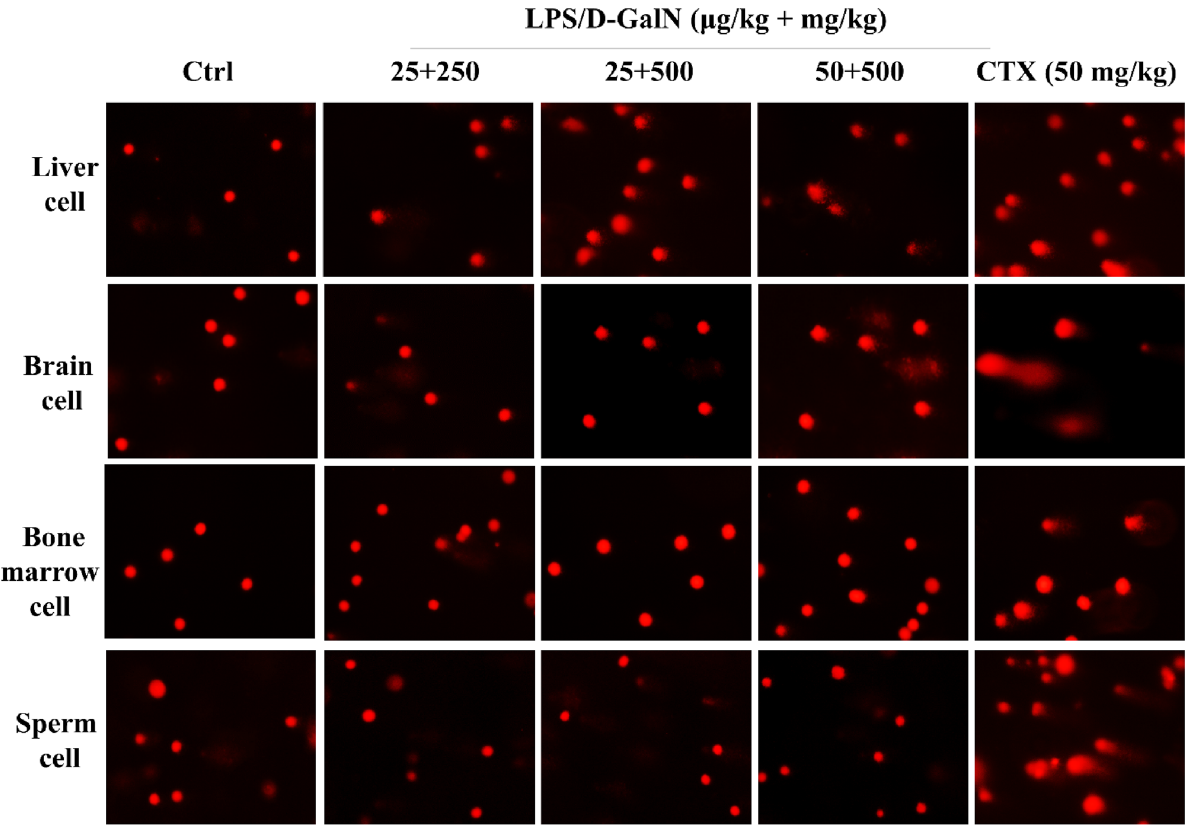
Figure 2. SCGE assay indicating acute LPS/D-GalN exposure induced DNA damage in different cells. Mice were injected intraperitoneally with LPS/D-GalN (25 μg/kg + 250 mg/kg, 25 μg/kg + 500 mg/kg and 50 μg/ kg + 500 mg/kg body weight), which were sacrificed after 6 h for tissue sample extraction. Saline solution (0.9%) and cyclophosphamide (CTX) (50 mg/kg body weight) were used as negative and positive control, respectively. SCGE assay was performed using cells from each tissue. The comet’s trailing image was captured by a fluorescence microscope (OLYMPUS